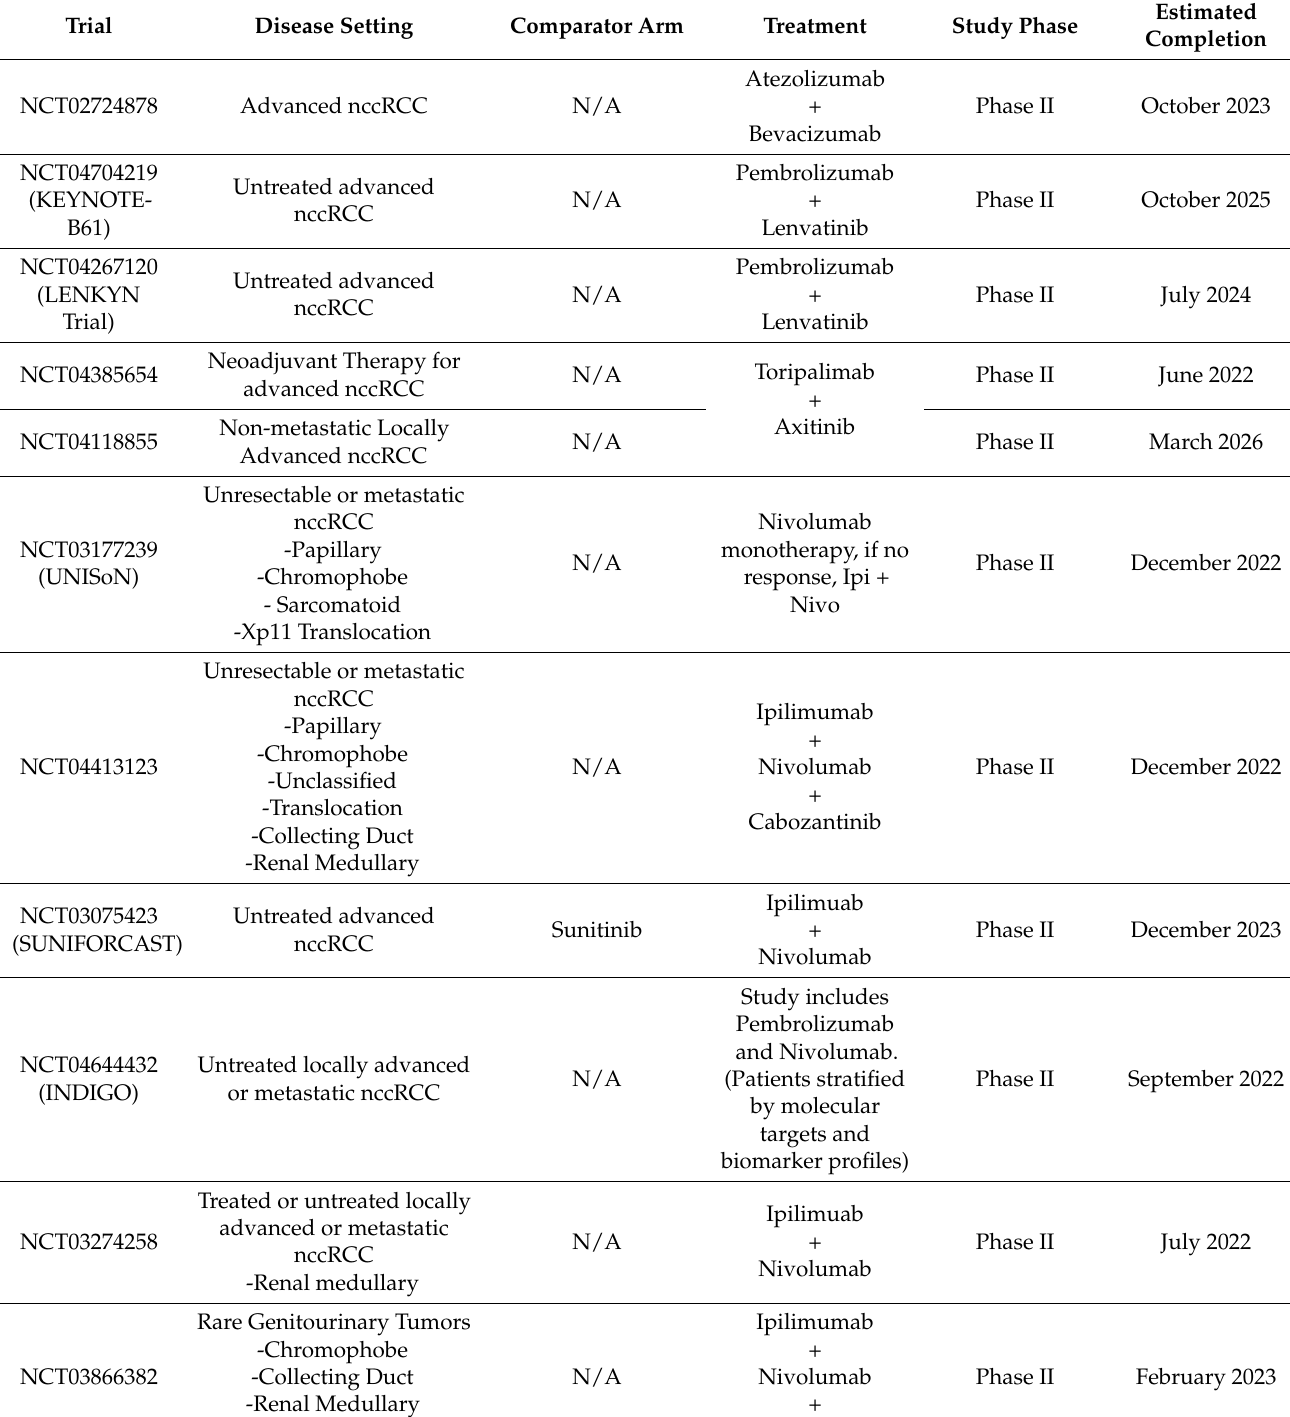
Table 2. Active prospective studies for patients with nccRCC employing immunotherapy. Trial Study Phase